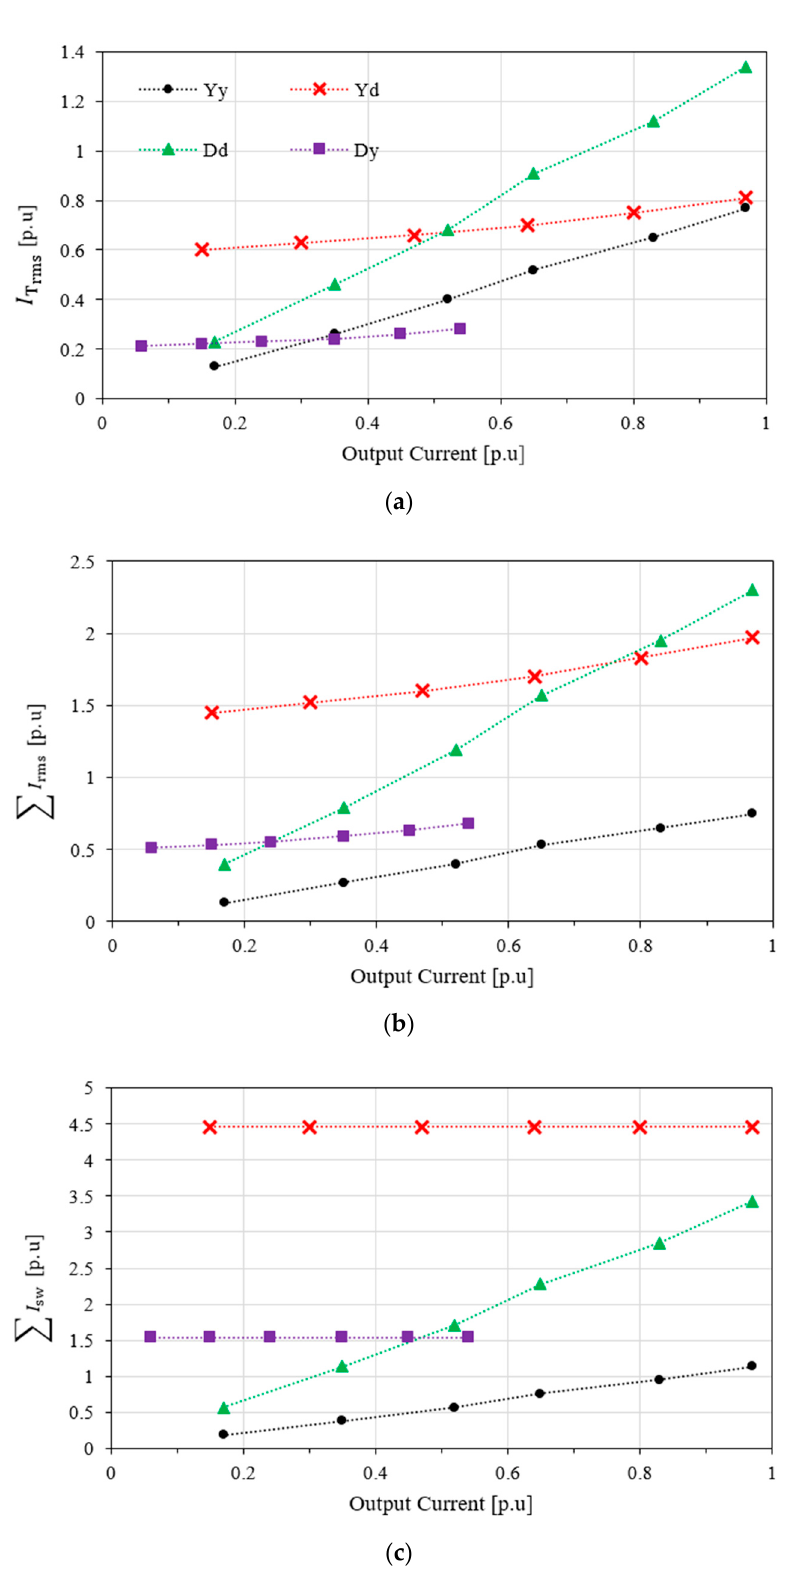
Figure 11. Current stresses in 3P-BIDC. ( a ) Transformer rms phase current. ( b ) Summation of the rms currents in one phase of bridges 1 and 2. ( c ) Summation of currents at switching instants in one phase of bridges 1 and